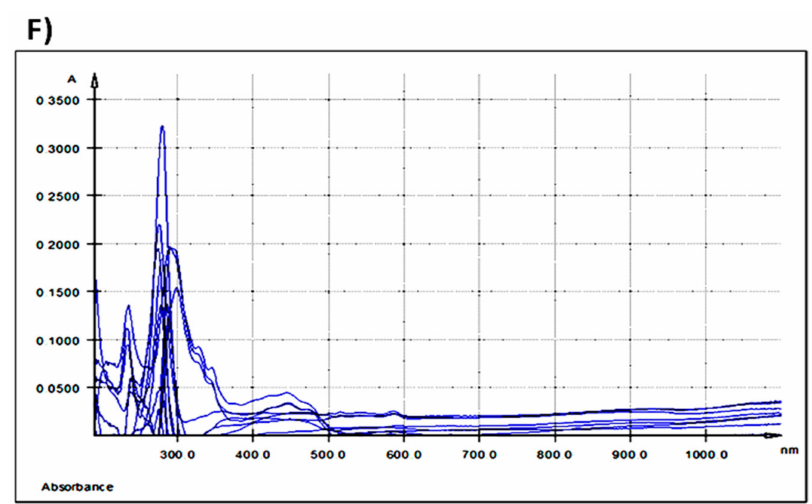
Figure 2. UV-Vis spectra: ( A ) extracellular medium (IPEC-1 cells) after 3 h of treatment with different AGP concentrations; ( B ) extracellular medium (IPEC-1 cells) after 24 h of treatment with different AGP concentrations; ( C ) intracellular matrix (IPEC-1 cells) after 3 h of treatment with different AGP concentrations; ( D ) intracellular matrix (IPEC-1 cells) after 24 h of treatment with different AGP concentrations; ( E ) differences between duodenum samples originating from the experimental (5% GP diet) and the control (no GP diet) groups; ( F ) differences between colon samples originating from the experimental (5% GP diet) and the control (no GP diet) groups; (a-red—250 ng GAE/mL AGP, b-green—500 ng GAE/mL AGP and c-blue—1000 ng GAE/mL